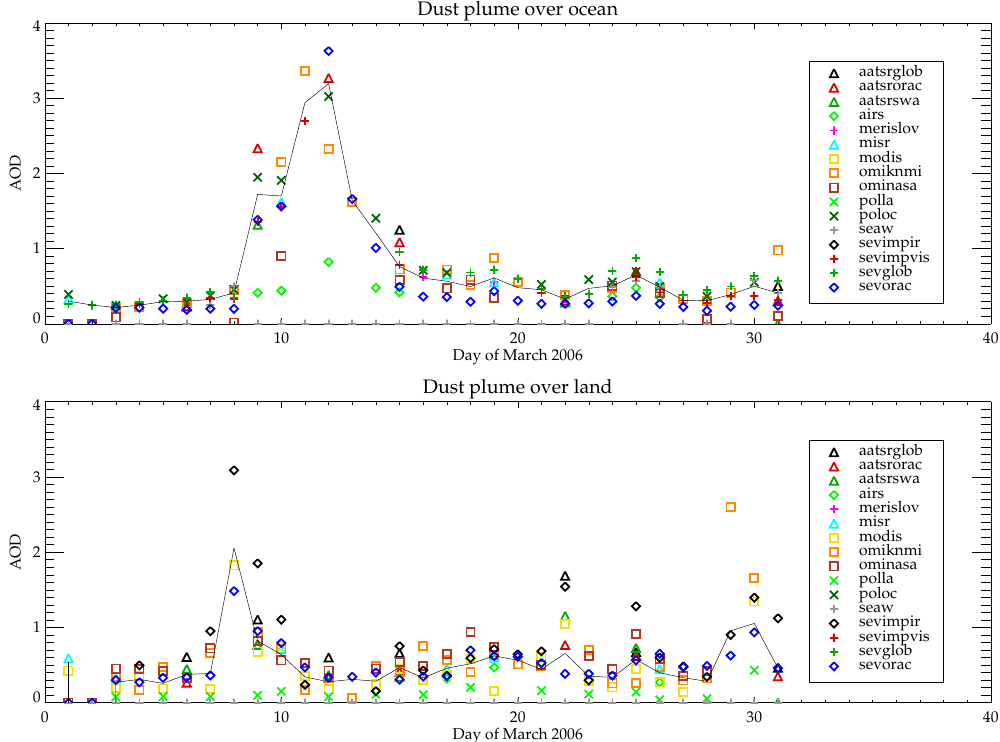
Fig. 11. Evolution of individual dataset AODs and averaged values (black line) as function of day of March 2006.